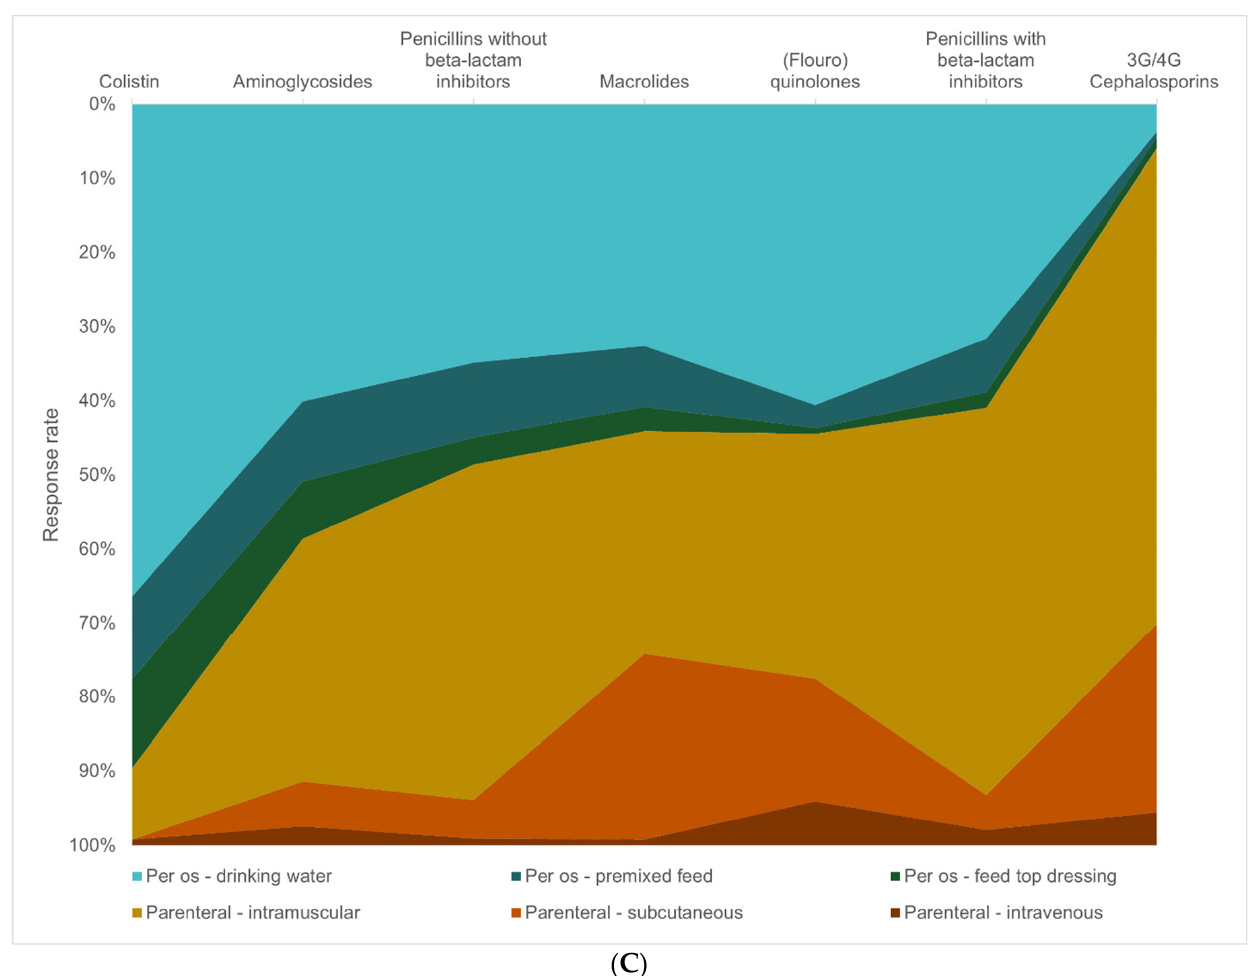
Figure 3. Most frequent models for metaphylactic treatment as indicated by responding veterinarians in percent (x-axis). ( A ): species (cattle, pigs, small ruminants and rabbits, poultry) and group size in five categories (0–15 animals, 16–30 animals, >30 animals, >100 animals, >1000 animals.) ( B ): stage of production (neonatal/ at hatching, at weaning, after transport/ newly grouped, fattening/rearing, breeding/ postpartum, in lay/lactation) and disease (gastrointestinal diseases, septicemia, respiratory diseases, locomotor diseases, neurological diseases, mastitis/metritis, musculoskeletal disorders). ( C ): antibiotic class (colistin, aminoglycosides, penicillins without beta-lactam inhibitors, macrolides, (flouro) quinolones, penicillins with beta-lactam inhibitors, 3G/4G cephalosporins), and route of administration (blue shades: per os-drinking water, per os-premixed feed, per os-feed top dressing, orange shades: parenteral-intramuscular, parenteral-subcutaneous, parenteral-intravenous). Veterinarians from all practice types considered increased mortality (n = 421/998, 42.2%) and increased morbidity (n = 201/998, 20.1%) to be the most significant health consequences if metaphylaxis were to be prohibited (multiple answer possible, all species- specific responses merged). For all practice types, except for poultry, the third most significant consequence according to responding veterinarians was decreased production and economic loss (n = 134/998, 13.4%). For poultry practitioners, the third most significant consequence was lower welfare (n = 34/184, 18.5%) (Table